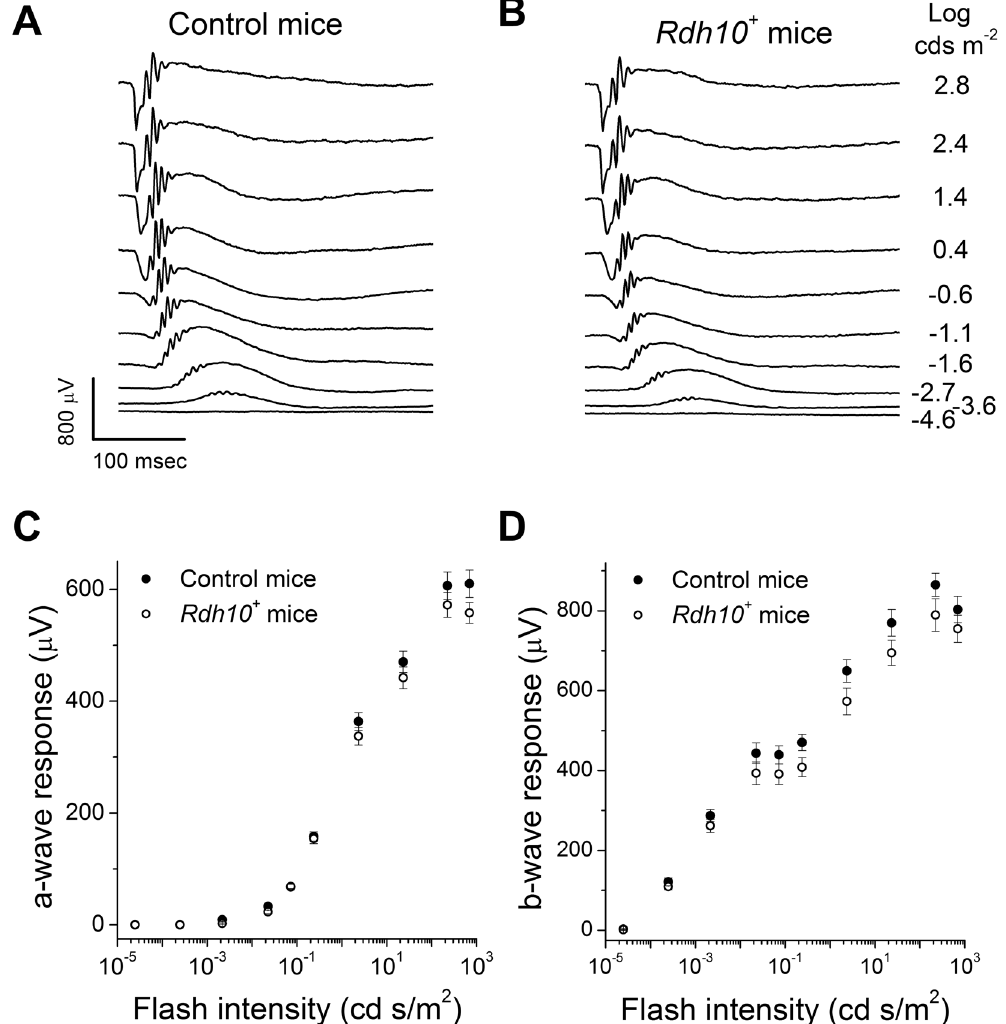
Figure 8. Ectopic expression of RDH10 in rod photoreceptor cells does not affect their photoresponses. Representative scotopic in vivo ERG responses from ( A ) control, and ( B ) transgenic Rdh10 ( Rdh10 + ) mice. ( C ) Ensemble-averaged scotopic a-wave responses ( C ) and scotopic b-wave responses ( D ) of control (n = 9, filled symbols) and Rdh10 + (n = 9, open symbols) mice measured by in vivo ERG